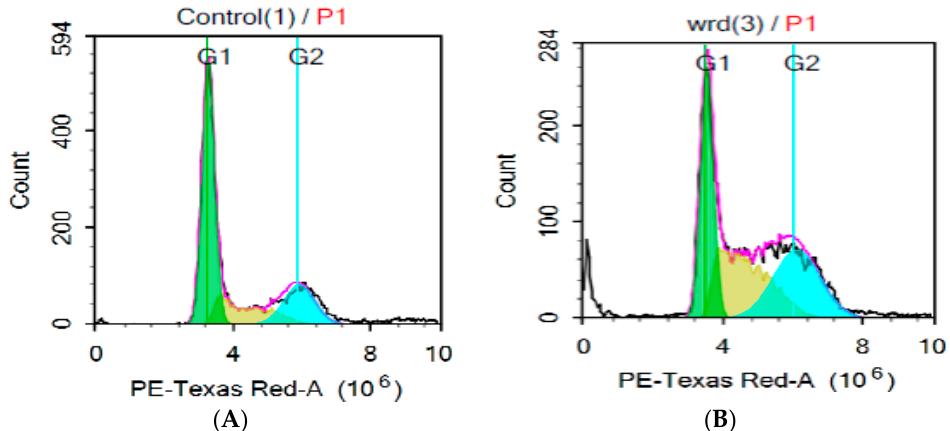
Figure 7. Effect of waste Taif rose (WTR) on the cell cycle distribution of HepG2 cells. The cells were exposed to WTR ( B ) for 48 h and compared to control cells ( A ); cell cycle analysis was determined by using DNA cytometry analysis, and different cell phases were plotted as % of total cellular events; the sub-G cellular population was taken as representative of the apoptosis/necrosis phases. Data are expressed as mean ± SE; n = 3; ( A ) Control, ( B ) WTR.